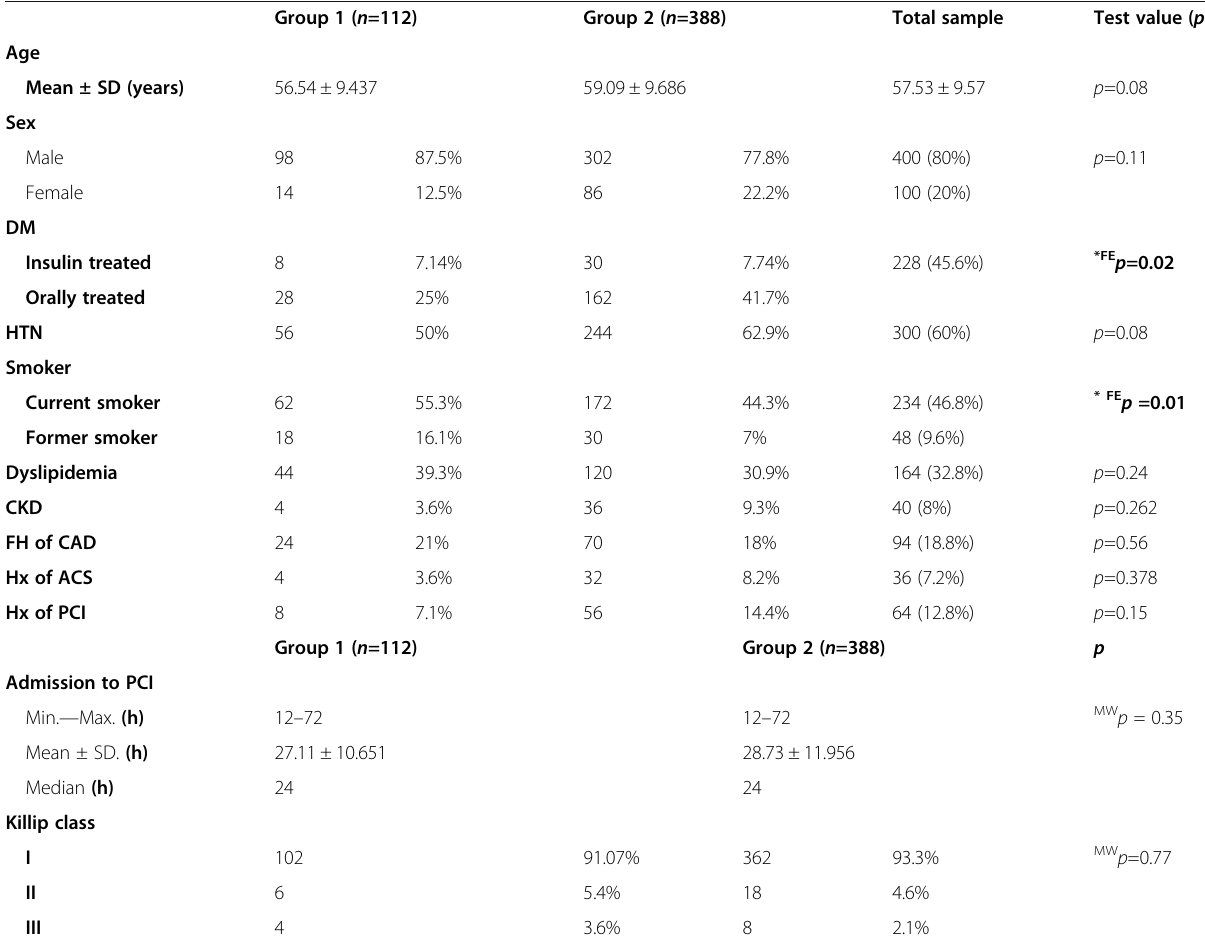
Table 1 Baseline characteristics of the studied